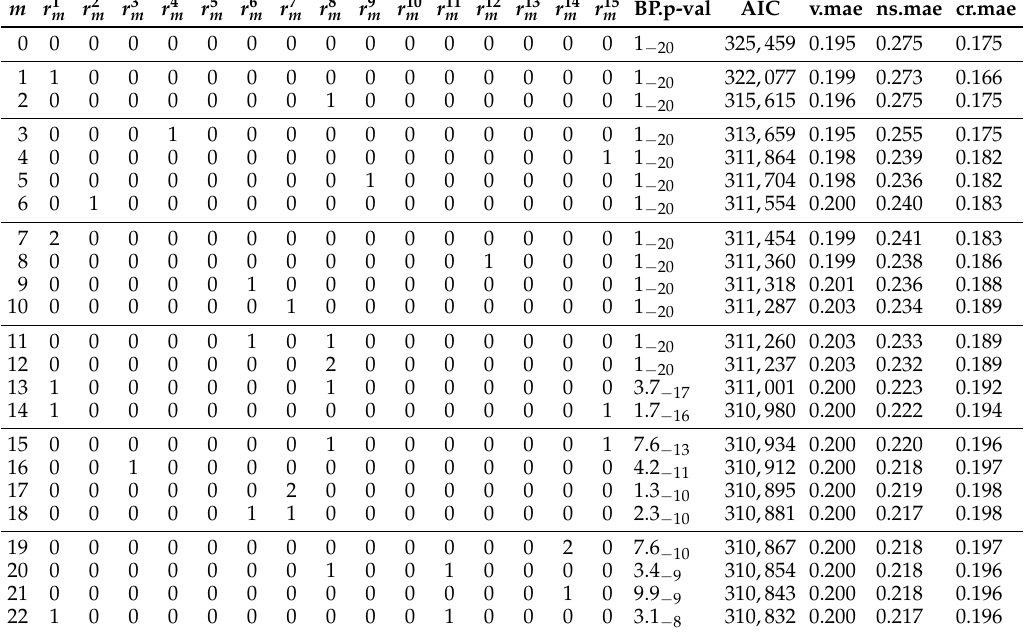
Table A25. FGLS variance models of BEL corresponding to M max adaptive selection from the set of basis functions of the 300–886 OLS proxy function given in Table A3 with exponents summing up to at max two. Furthermore, p -values of Breusch-Pagan test, AIC scores and out-of-sample MAEs in % after each